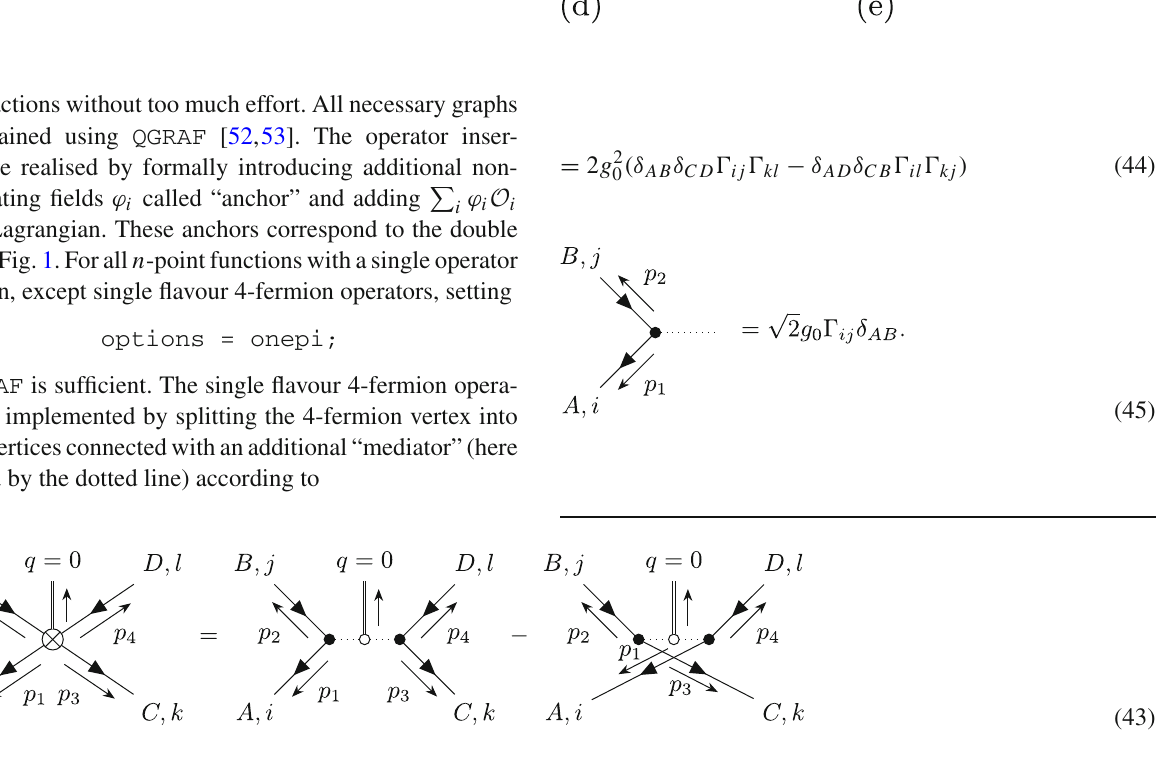
Fig. 1 Graphical representation of all 1PI graphs of fundamental quark fields or background fields with insertion of an operator O or E considered for the renormalisation of the basis. Here the double line indicates the momentum contribution of the inserted operator, which may also be seen as an additional leg and is set to zero momentum. The wiggly lines are external background fields and the straight lines carrying arrows are quarks. The graph (e) is only needed at mass-dimension 6 to include 4-fermion operators